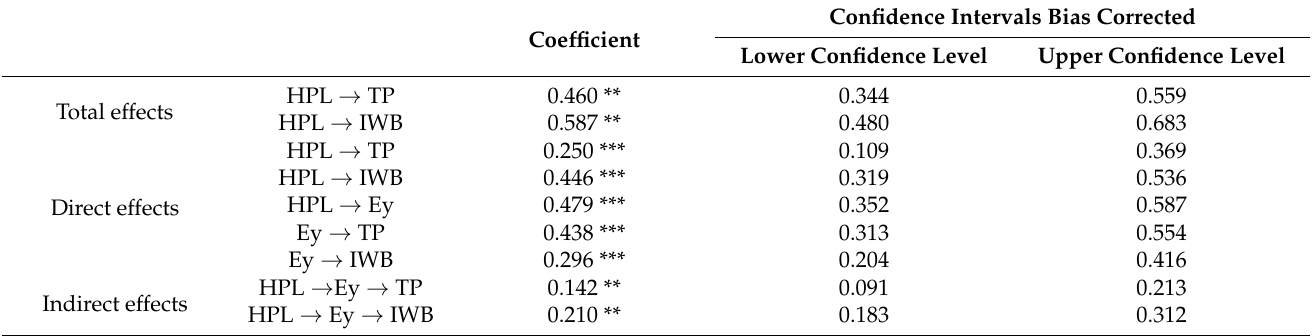
Table 4. The effect of health-promoting leadership on positive workplace outcomes through